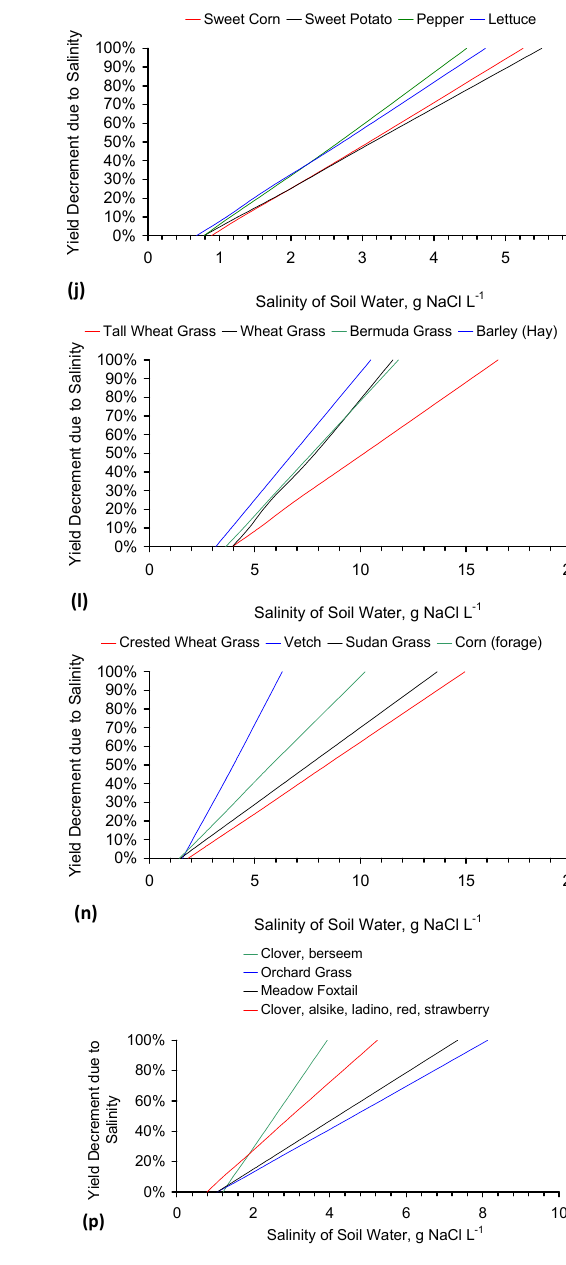
Figure B1. Indicative relationship between crop yield and soil water salinity. ( a ) Barley, Cotton, Sugar Beet, Wheat; ( b ) Safflower, Soybean, Sorghum, Groundnut; ( c ) Rice, Sebania, Flax; ( d ) Broad bean, Cowpea, Beans; ( e ) Date Palm, Fig, Pomegranite, Olive, Grapefruit, Orange, Lemon, Pear, Apple, Walnut; ( f ) Peach, Apricot, Grape, Almond, Plumb; ( g ) Blackberry, Boysenberry, Avocado, Raspberry, Strawberry; ( h ) Beets, Broccoli, Tomato, Cucumber; ( i ) Cantaloupe, Spinach, Cabbage, Potato; ( j ) Sweet Corn, Sweet Potato, Pepper, Lettuce; ( k ) Radish, Onion, Carrot; ( l ) Tall Wheat Grass, Wheat Grass, Barley (Hay), Bermuda Grass; ( m ) Perrenial Rye Grass, Harding Grass, Trefoil, birsdfoot narrow leaf, Tall Fescue; ( n ) Crested Wheat Grass, Vetch, Sudan Grass, Corn (forage); ( o ) Wid Rye, beardless, Trefoil, big, Alfalfa, Lovegrass; ( p ) Clover, berseem, alsike, ladino, red, strawberry, Orchard Grass, Meadow Foxtail. Data Source: